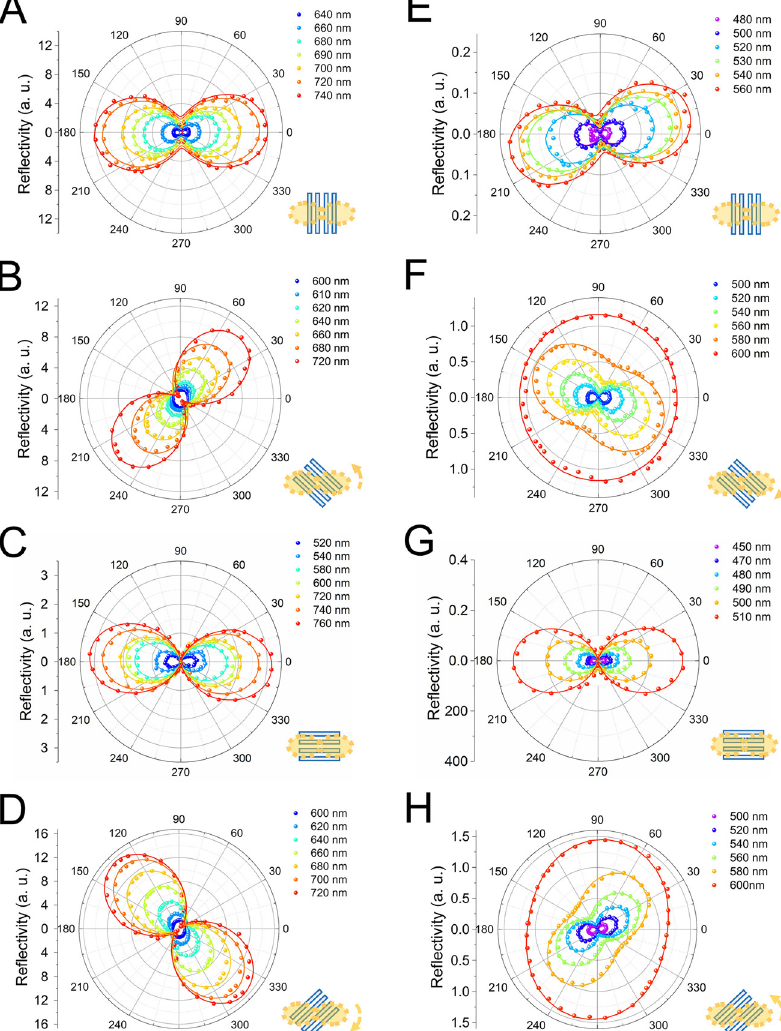
Figure 3: Polarization control over the reflected light of